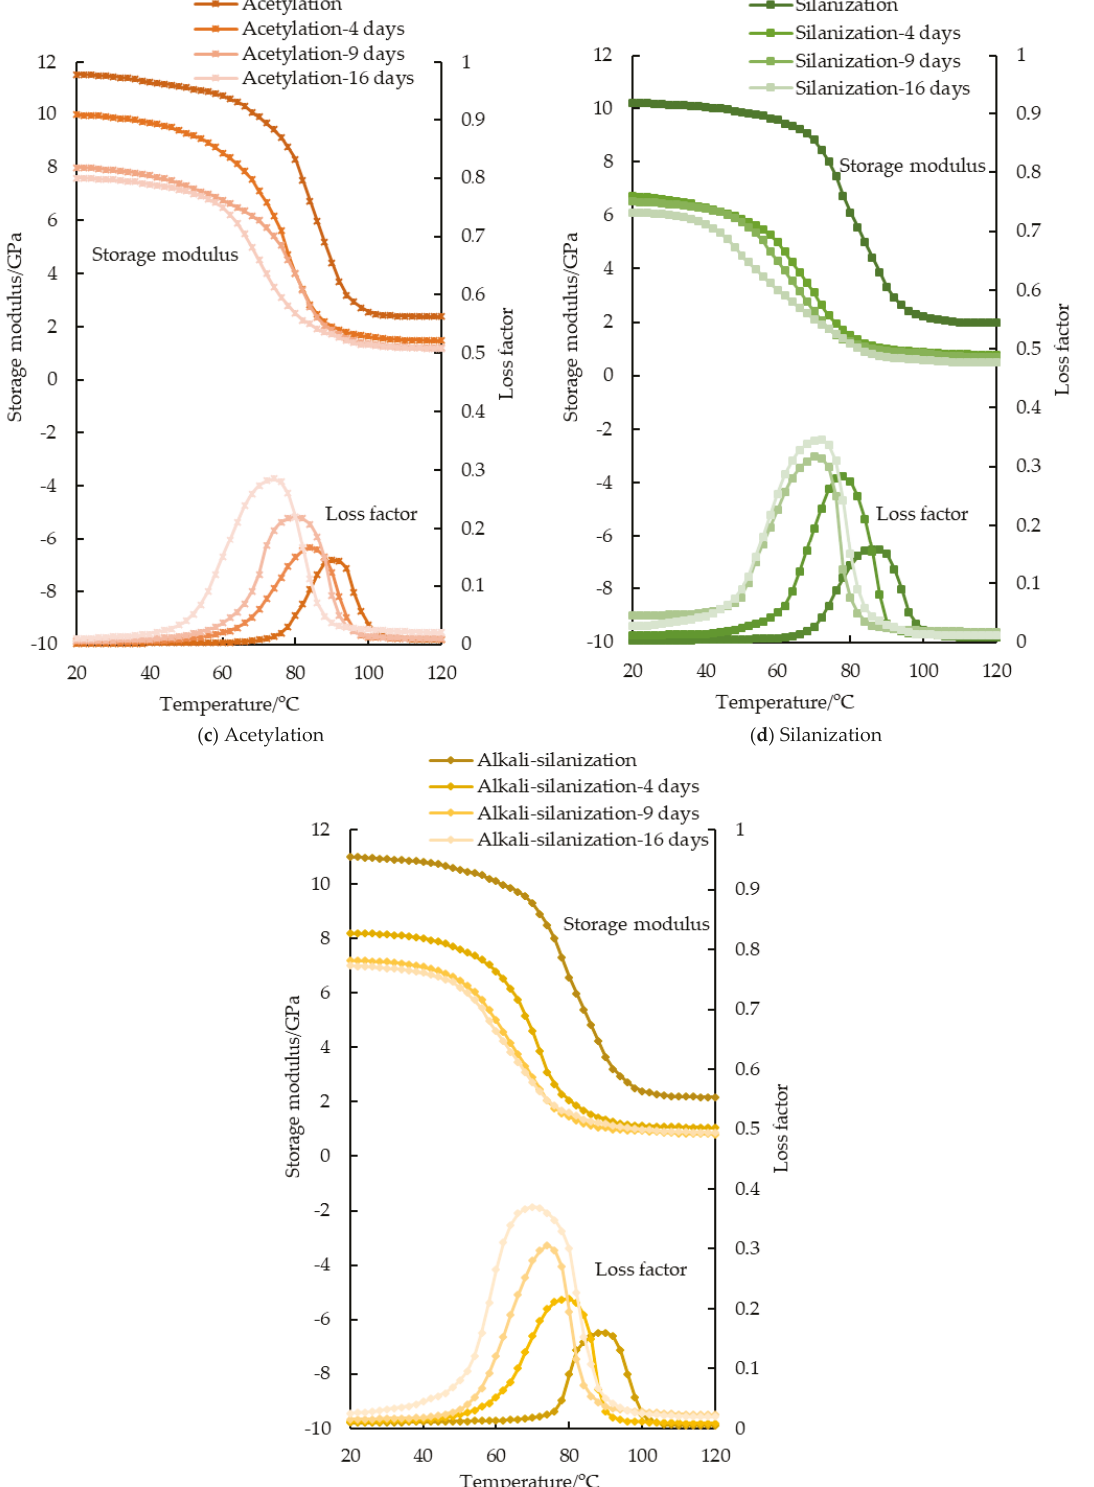
Figure 3. Storage modulus and loss factor of FFRP after hygrothermal